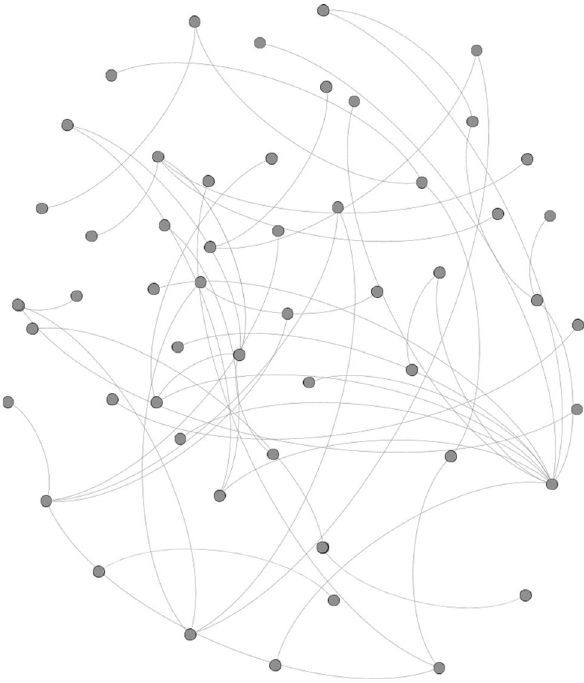
Figure 1. Pre-crisis financial network estimated by TVP-VARs. The figure features an illustrative snapshot of the network estimated by TVP-VARs for a pre-crisis period (September 2006). Nodes represent the financial institutions of our sample and edges their relationships as revealed by the Granger-causality testing over the time series of their respective log-returns (see the supplementary information or 2 for more